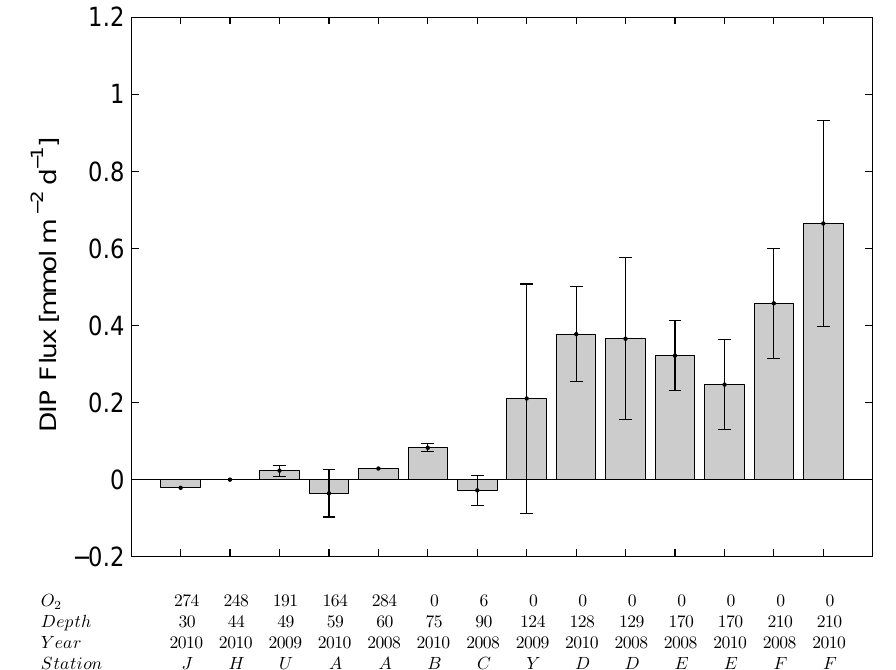
Fig. 7. Benthic DIP effluxes and up-take rates presented as station averages from each year. Error bars indicate 95% confidence interval, and its magnitude was mostly related to sediment spatial variability. The fluxes are sorted after bottom depth, with the shallowest station to the left and increasing bottom depth to the right. The labels on the x-axis are from top to bottom; bottom water oxygen concentration in µM, measured at the start of the incubation inside the chambers; bottom depth in m; year of sampling; and station name. Table 2. Mean values of the DIP flux (mmolm − 2 d − 1 ) for the different depth ranges and bottom with oxic, hypoxic and anoxic bottom water (BW) conditions. Standard deviation ( σ ), confidence interval (CI) and number of incubations ( n ) are given in the last three columns. Group, (Stations) Depth Bottom BW O 2 DIP flux σ range